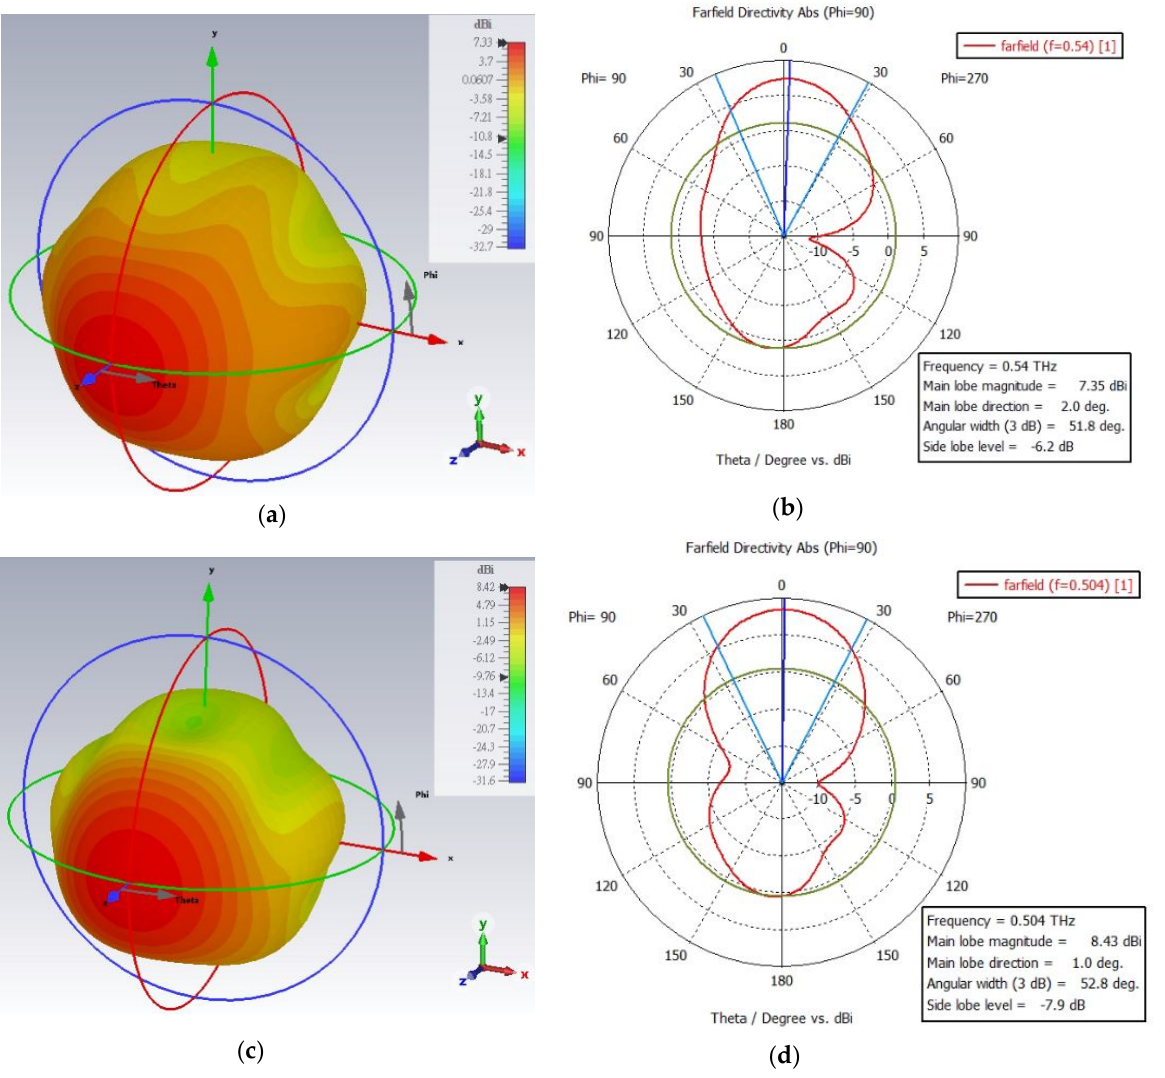
Figure 6. The 3D and polar plot of the farfield radiation pattern of the one segment Hilbert fractal reconfigurable antenna from ( a , b ) ordinary (at 0.54 THz) to ( c , d ) extraordinary (at 0.504 THz) polarization in the PDLC.